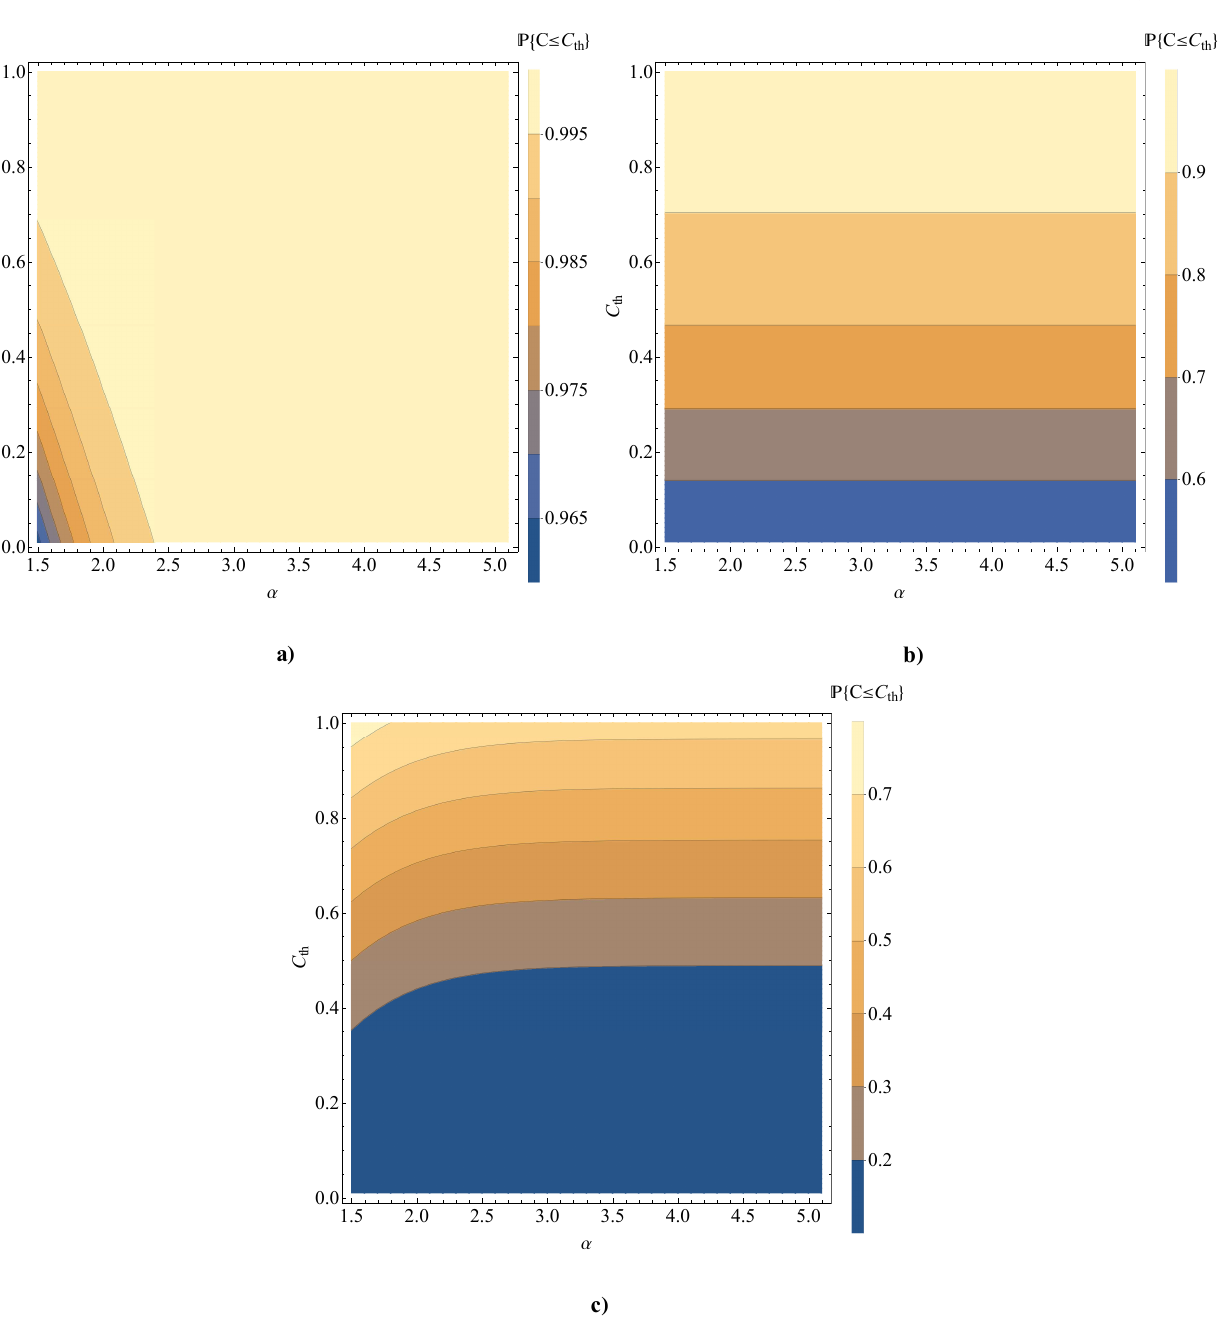
LoS and NLoS components (i.e., Ω X = Ω Y = − 5 dB in Figure 7a, or Ω X = Ω Y = 5 dB in Figure 7c) the difference of P out as a function of m X , m Y is almost intractable. In those cases, the area with P out < 0.1 (where the secrecy constraints are satisfied) is concentrated where m X , m Y are large, which corresponds to the small overall and LoS component shadowing, and the equiprobability contours are almost parallel to the m Y axis (thus the values m Y do not impact) for m X < 4, m Y > 6 in case of P out = 0.2 and for m X < 2, m Y > 3 in case of P out = 0.3. On the other hand, for large values of m X and small m Y the lines of P out = const are almost parallel to m X , thus m Y does not have any impact on the link security.